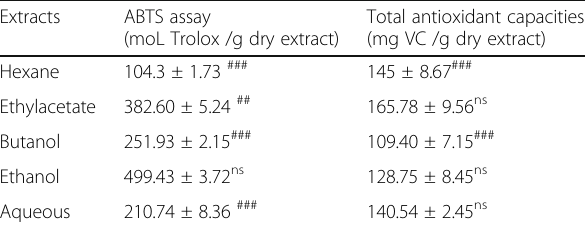
Table 3 Antioxidant activities of Cynara scolymus leaves extracts Extracts ABTS assay (moL Trolox /g dry